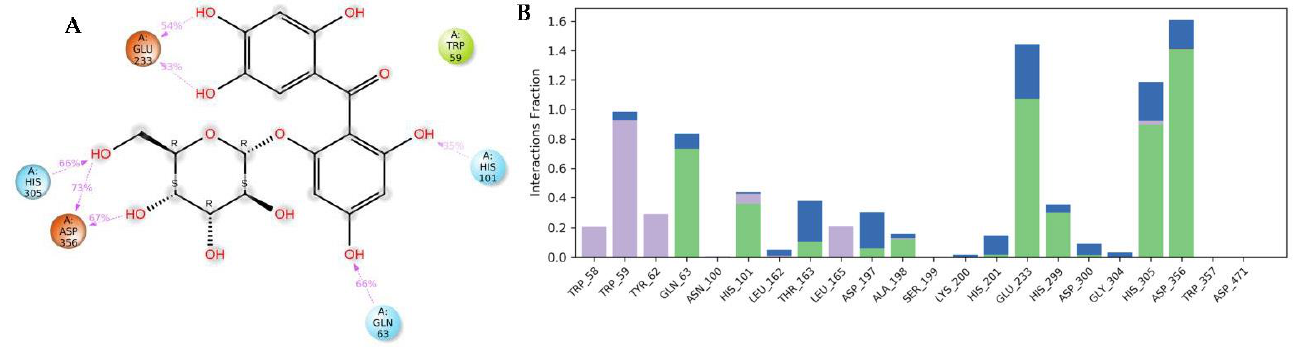
Figure 10. Analysis of molecular interactions and types of contacts with alpha-amylase after MD simulation. ( A ) Detailed schematic interaction of 8 with the binding site residues of alpha-amylase in color scheme, where orange represents the charged, blue represents the polar, and light green represents the hydrophobic residues (PDB ID:4GQR). ( B ) Normalized stacked bar chart of the alpha- amylase binding site residues interacting, with 8 showing the main types of bonding interaction: hydrogen bonds (green), hydrophobic (violet), and water bridges